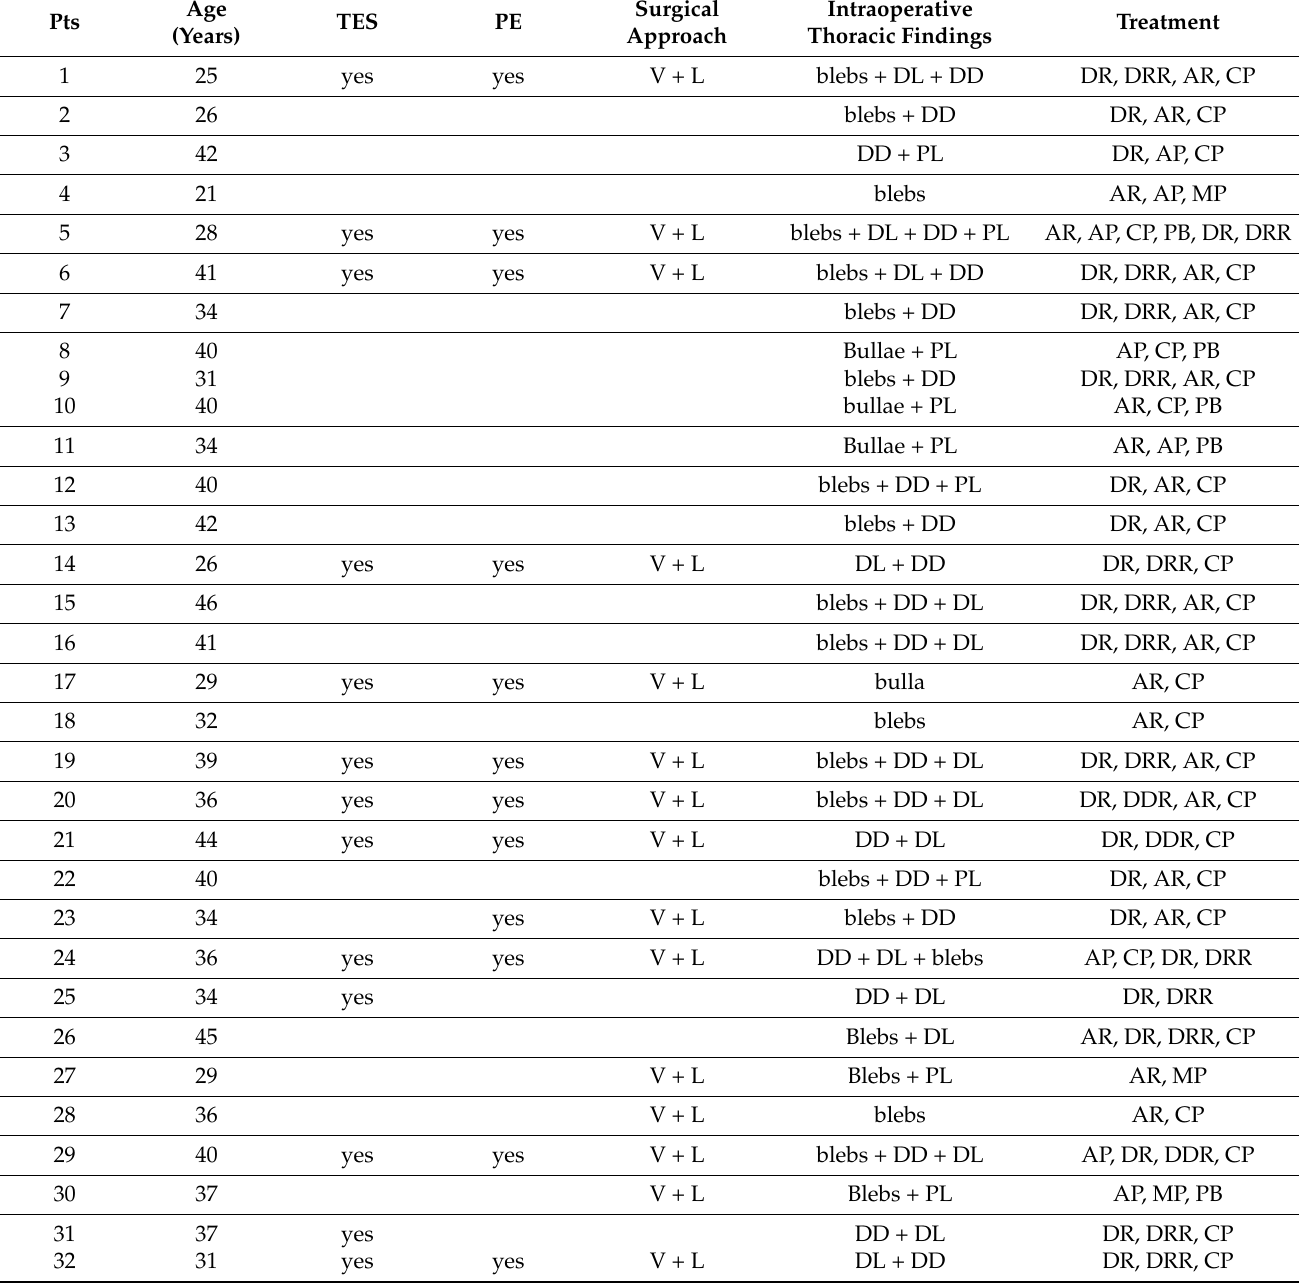
Table 1. Surgical procedures performed in